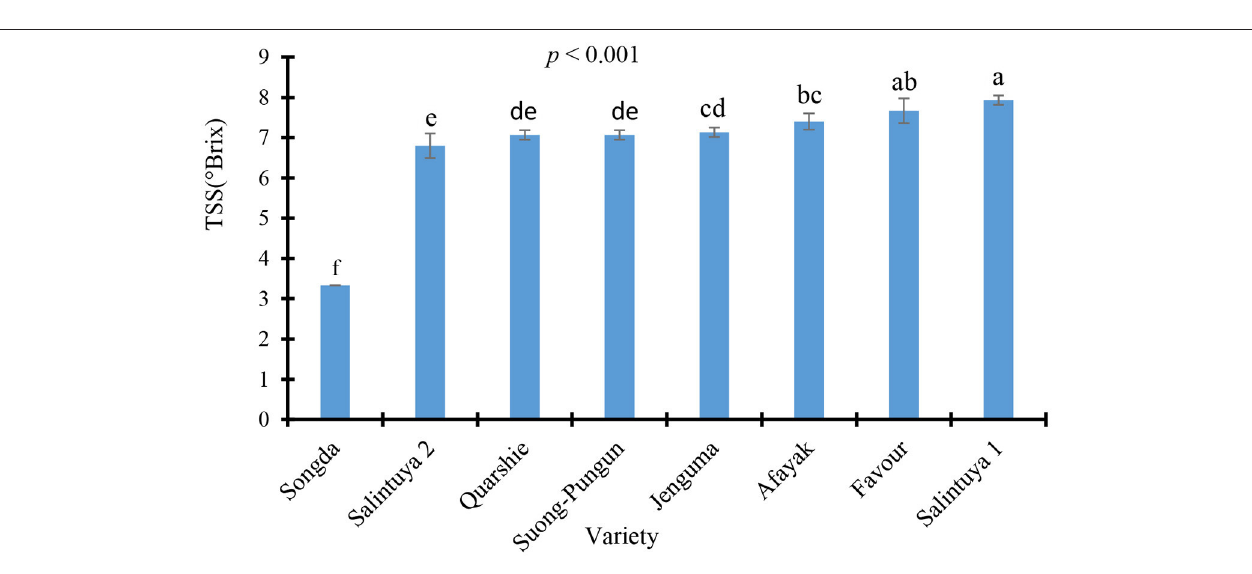
( Figure 1 ). Fermented cassava and the oven-dried okara were mixed in ratios: 80:20, 70:30, and 50:50 on, as-is basis. The mixtures were then roasted separately at 84–95 ◦ C for 25–30 min. The samples were allowed to cool, sifted with a 355 µ m